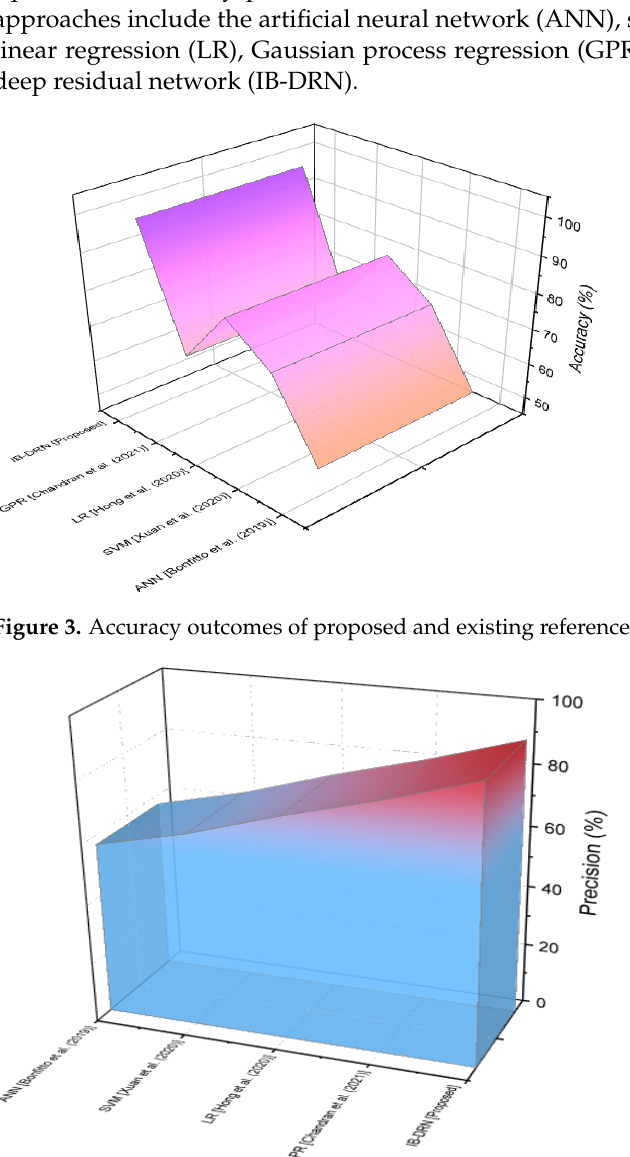
Figure 5. Recall results of proposed and existing methodologies [ANN [Bonfitto et al. (2019)], SVM[Xuan et al. (2020)], LR[Hong et al. (2020)], GPR [Chandran et al. (2021)]]. By dividing the real positives by anything else which should have been projected as positive, recall (also known as the true positive rate) is obtained. The recall results utilizing both the suggested and current methodologies are shown in Figure 5. Figure 5 above demonstrates that the suggested approach of IB-DRN has a higher recall than the existing methods. Equation (35) is given below: